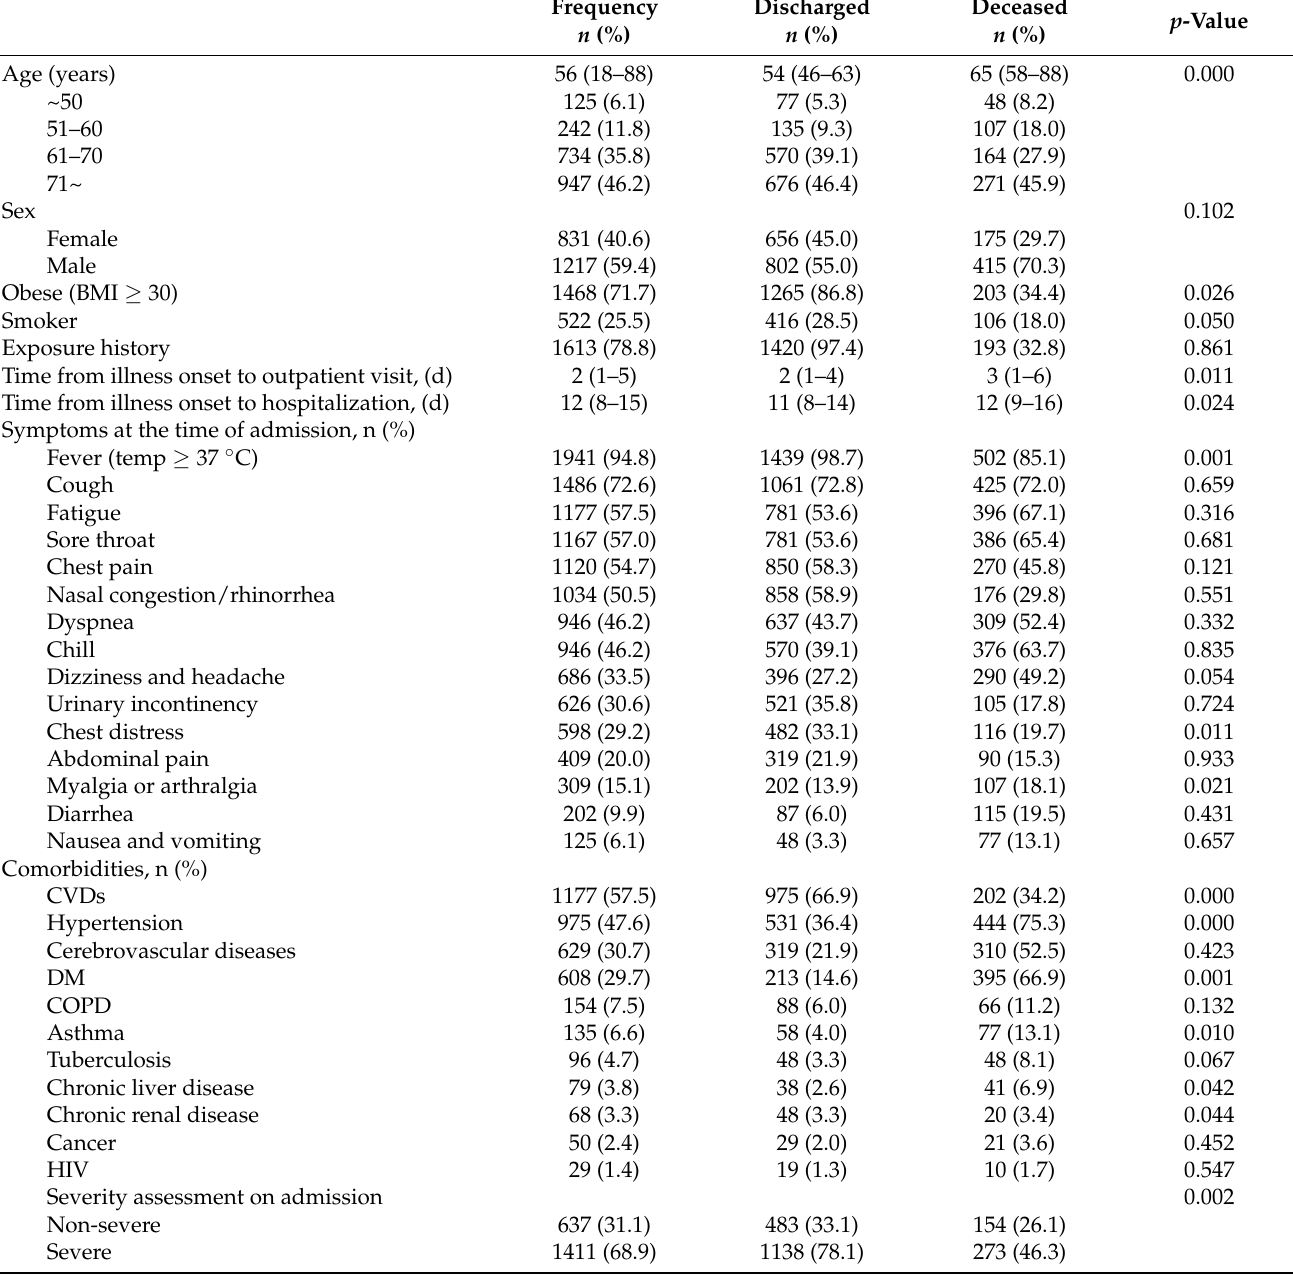
Table 1. Demographic and clinical characteristics of COVID-19 patients and in-hospital